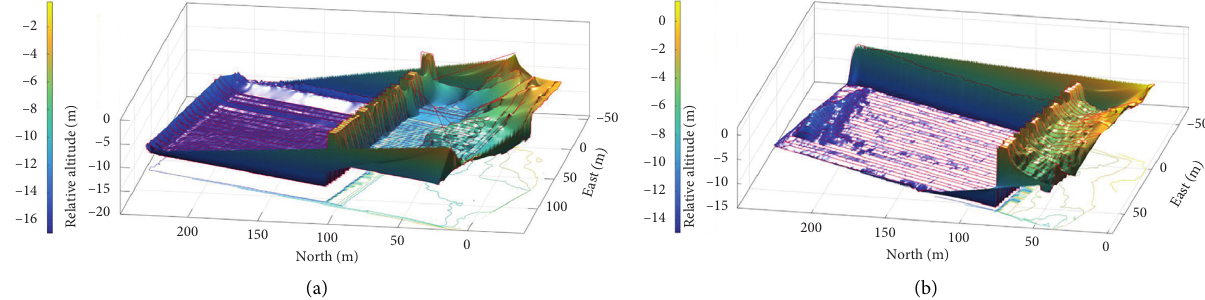
Figure 13: Three-dimensional underwater topography of stilling basin. (a) Surface outlet stilling basin. (b) Bottom outlet stilling basin.